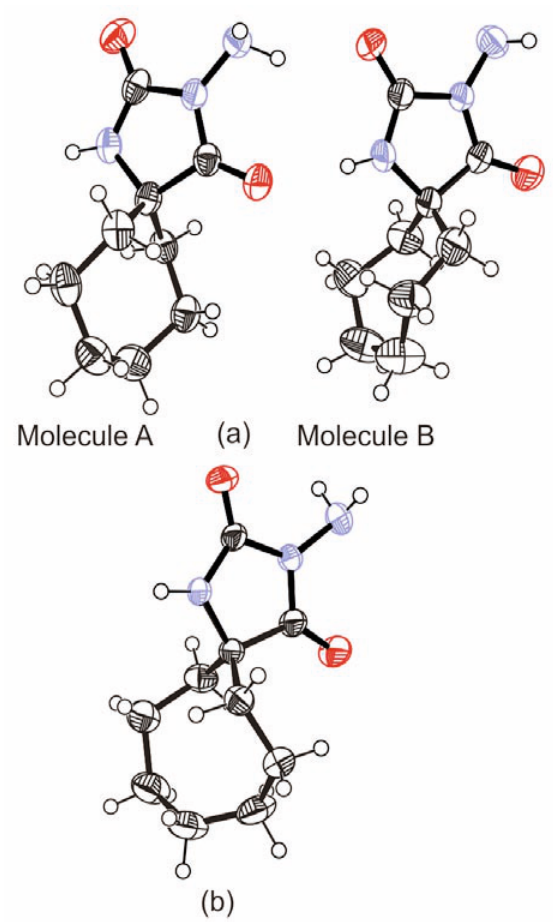
Figure 1. ORTEP drawings of the basic crystallographic units: (a) 3-amino-cycloheptanespiro-4’-imidazolidine-2’,5’-dione (I); (b) 3-amino- cyclooctanespiro-4’-imidazolidine-2’,5’-dione (II). The hydrogen atoms are shown as small spheres of arbitrary radii.